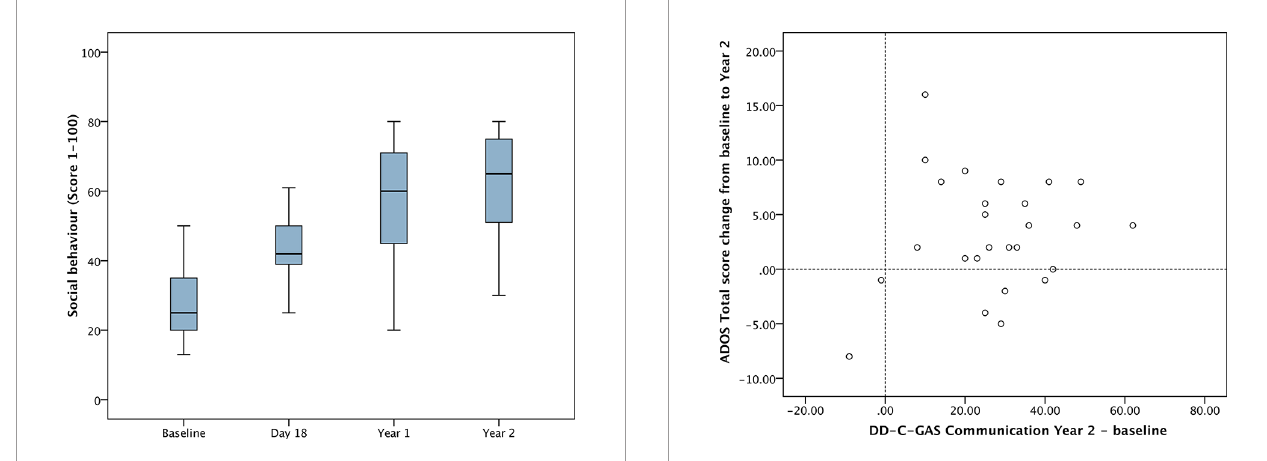
FIGURE 5 | Scatterplot: ADOS Total score change versus DD-C-GAS Communication change (N = 26). Changes for ADOS scores were calculated as differences baseline – Year 2 to present improvements as positive